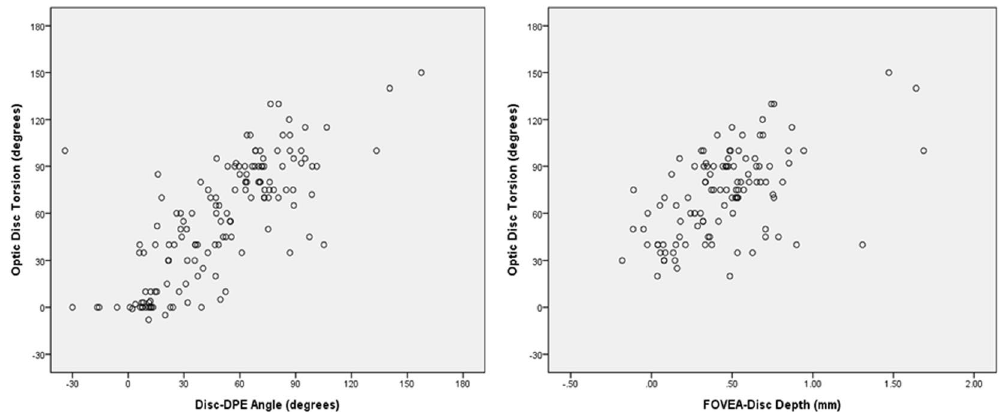
Figure 6. Scatter plot showing the degree of optic disc torsion and the Disc-DPE angle were significantly correlated ( r = 0.548 and P < 0.001) and the Fovea-Disc depth were also significantly correlated with the degree of optic disc torsion ( r = 0.544 and P <